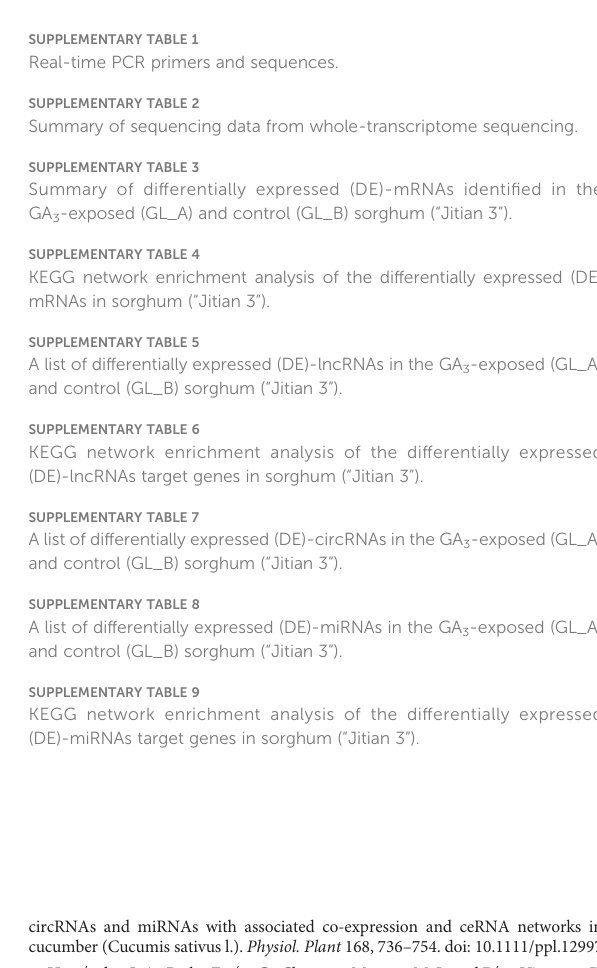
SUPPLEMENTARY TABLE 1 Real-time PCR primers and sequences. SUPPLEMENTARY TABLE 2 Summary of sequencing data from whole-transcriptome sequencing. SUPPLEMENTARY TABLE 3 Summary of differentially expressed (DE)-mRNAs identi fi ed in the